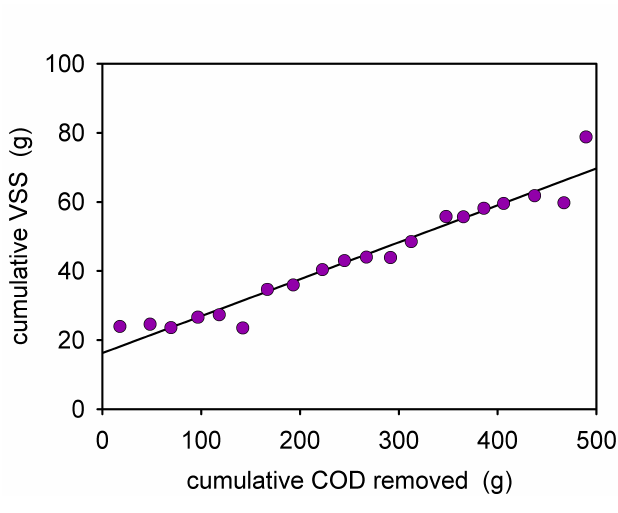
Figure 8. Cumulative VSS produced as a function of cumulative COD removed in SBR12 for a period of 168